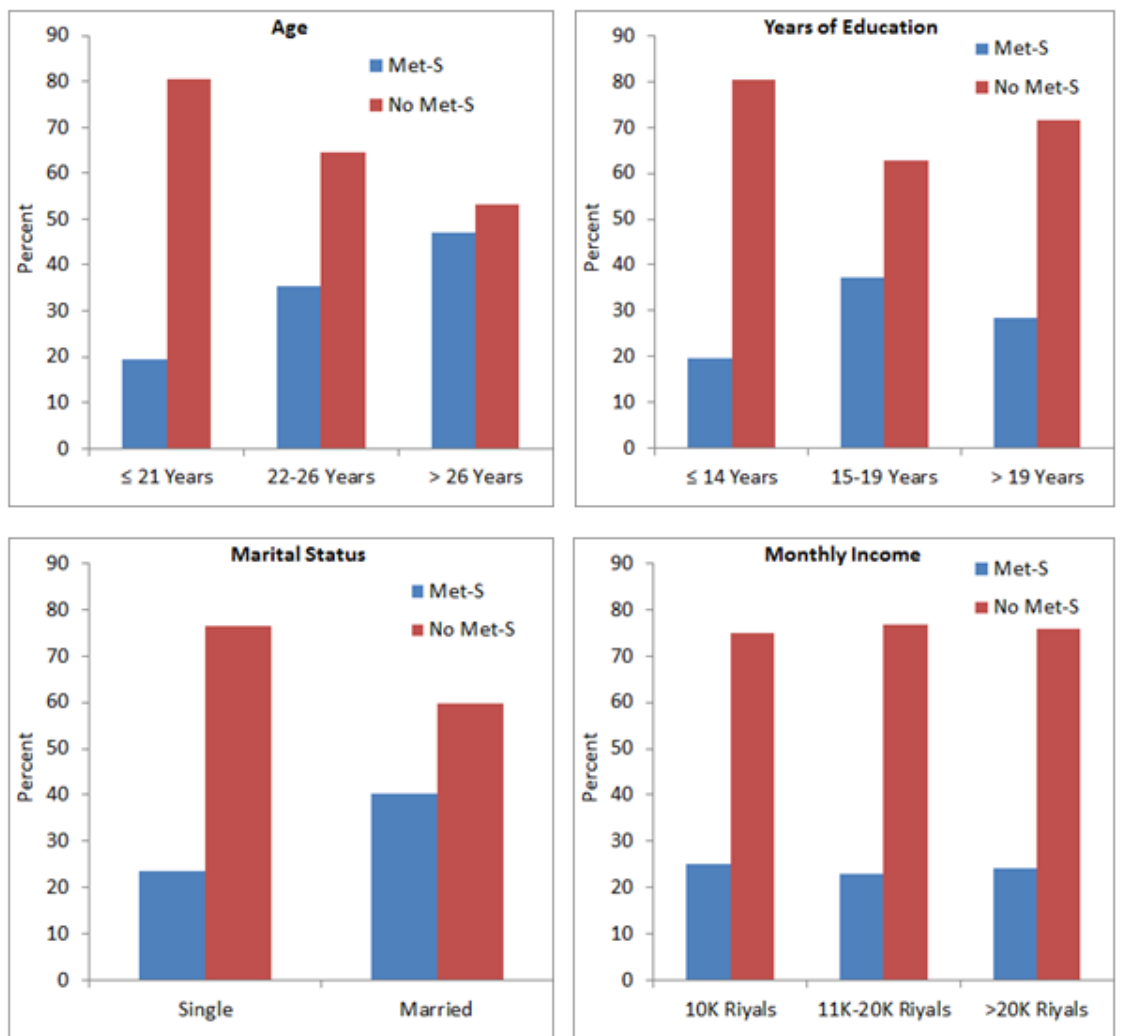
Figure 2. Association between Met-S and age, education, marital status and monthly income.